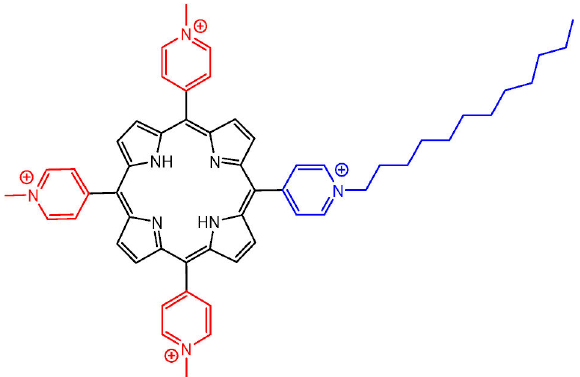
Figure 10. Molecular structure of an amphiphilic water-soluble tetra-cationic porphyrin with good activity against malaria parasites, by Stallivieri et al.